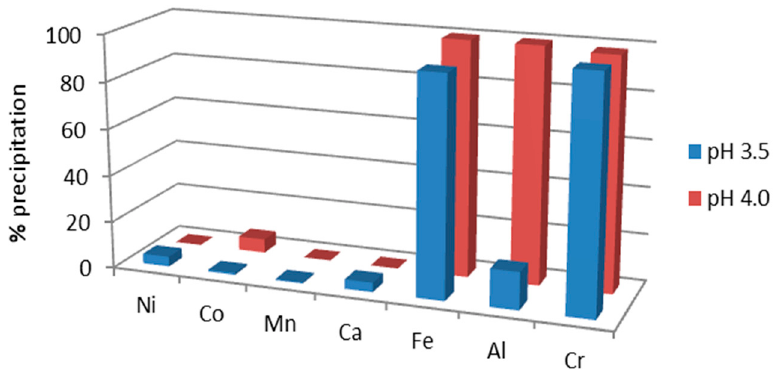
Figure 9. Metal removal (%) from PLS during the precipitation of trivalent metals step.